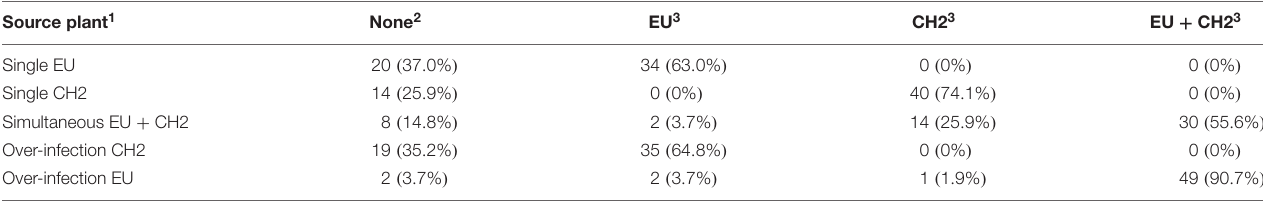
FIGURE 3 | Effect of PepMV-EU over-infection on virus accumulation. PepMV-EU (A) and PepMV-CH2 (B) accumulation was measured in plants pre-inoculated with PepMV-CH2 and challenged with PepMV-EU. Single PepMV-EU and simultaneous infections between PepMV-EU + PepMV-CH2 were included as controls. Over-inoculations were carried out at different times after pre-inoculation (3, 6, 8, 10, and 14 days). Viral accumulation was determined for three plants for each time point by absolute RT-qPCR and showed as ng viral RNA/100 ng total RNA; each bar represents the mean and its standard deviation. Asterisks show significance level (** p < 0.01; *** p < 0.001). TABLE 1 | Efficiency of PepMV-EU and -CH2 mechanical